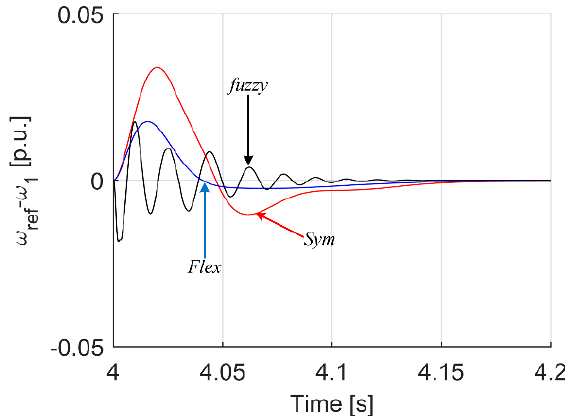
Figure 12. Transients of motor, load and reference speed for analyzed controller cases.